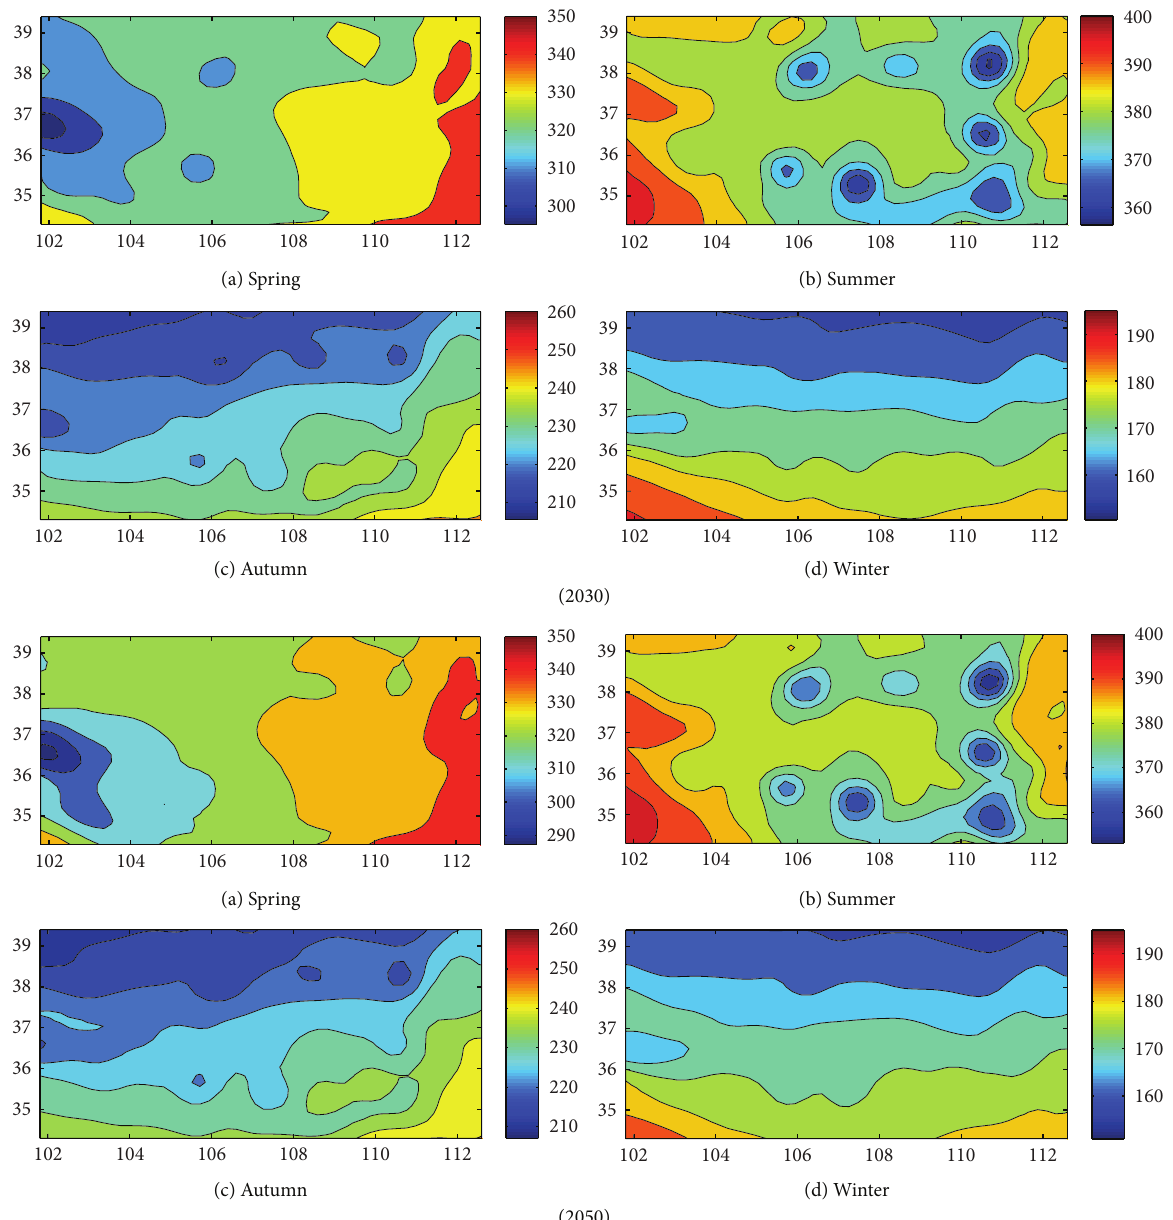
Figure 3: Downward short wave radiation in 2030 and